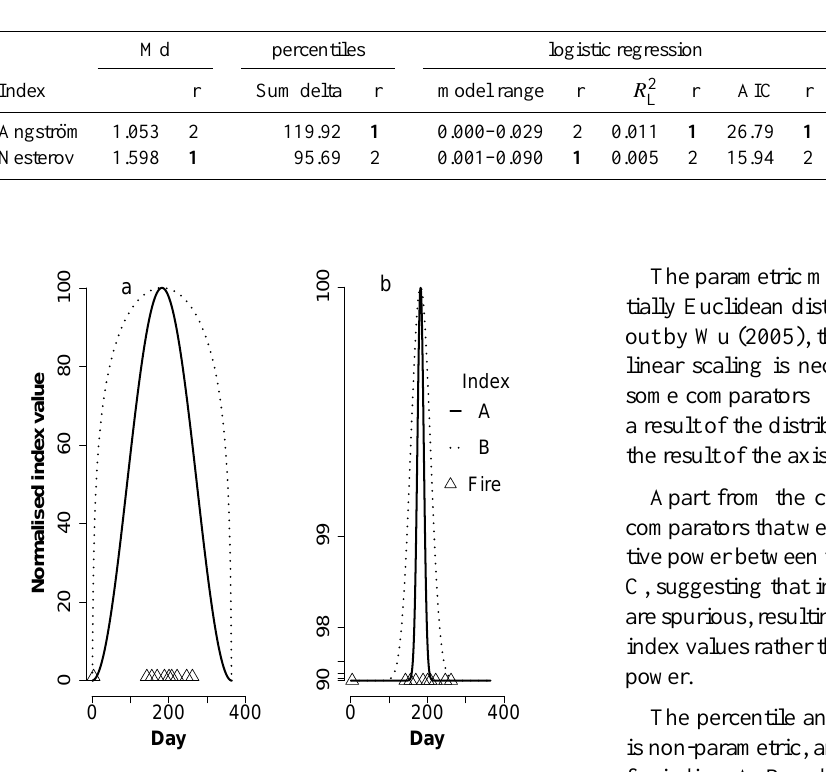
Table 2. Comparator values and ranks for each index applied to Angstr¨om and Nesterov indices in the Graz area. Bold numbers in the rank column indicate the “best” index according to each method.